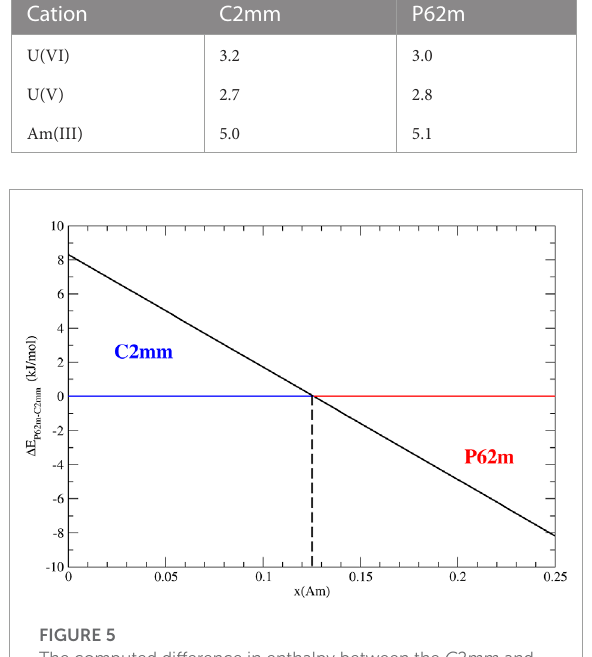
TABLE6 ThecomputedandmeasuredvolumesofpureandAmdoped U 3 O 8 (atAm/Uratioof1/9).Themeasureddataarethoseof Caisso et al. (2016).ThevaluesareinÅ 3